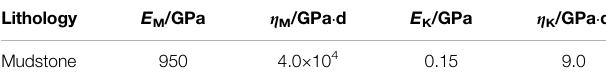
TABLE 3 | Creep parameters of roadway surrounding